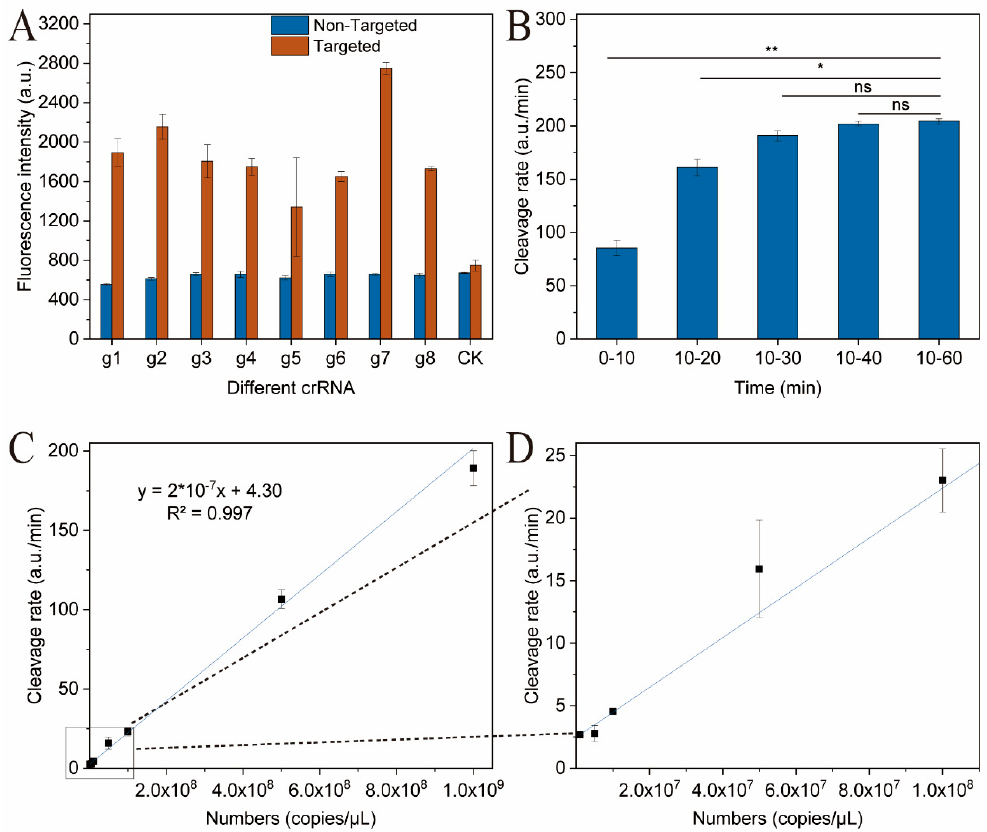
Figure 4. Specificity and detection range analysis of a CRISPR –Cas12a target DNA detection system for Lactobacillus panis . ( A ) Fluorescence intensity using different crRNAs (g1–g8) designed for L. panis . ‘Targeted’ indicates L. panis genomic DNA, and ‘Non-Targeted’ indicates a mixture of the genomic DNA of L. rhamnosus , L. rapi , L. pontis , L. paracasei , L. parafarraginis , L. fructivorans , L. fermentum , and L. amylovorus . ( B ) Detection time analysis. Here, we calculated the slope of the kinetic curve from 0 min to 60 min. * indicates significance at the 0.05 level; ** indicates significance at the 0.01 level; ns indicates no significance. ( C ) Stand curve of the cleavage rate and the target copy numbers of L. panis . ( D ) A magnified portion of the stand curve of the cleavage rate and the target copy numbers of L. panis (shown in B) from copy number 0 to 1.0 × 10 8 copies/ μ L.